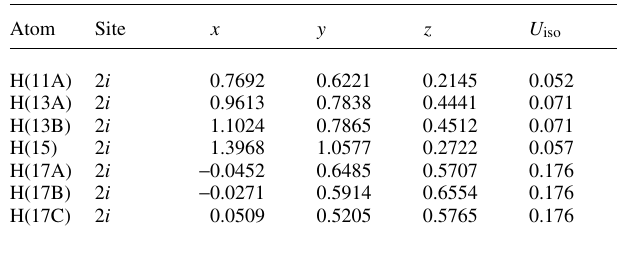
Table 2. Atomic coordinates and displacement parameters (in Å 2 )